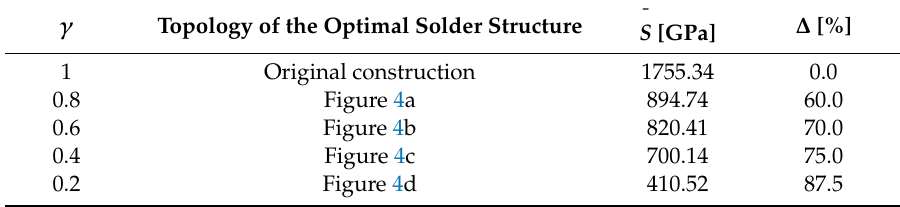
Table 1. Results of the topological optimization for the symmetric three-layer package.